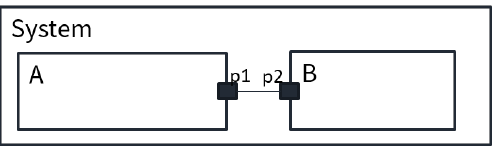
Figure 6. Example of a system